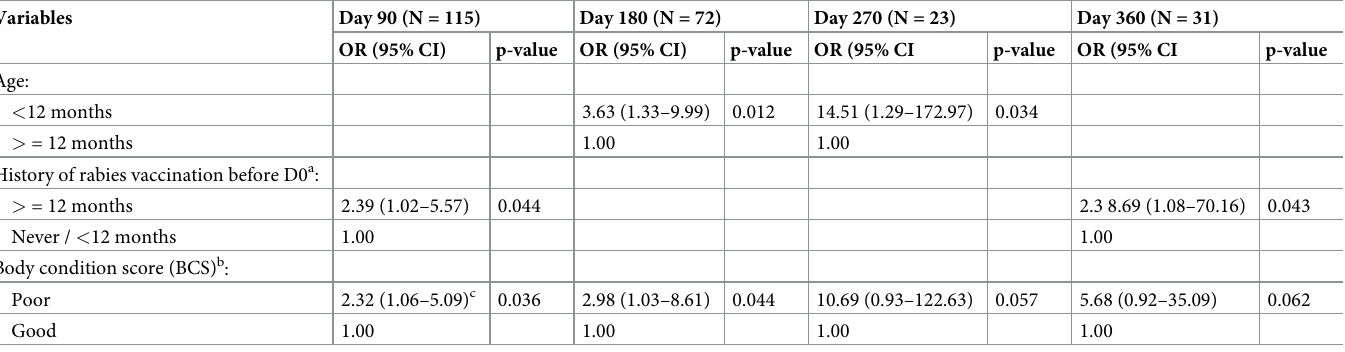
Table 4. Determinants associated with loss of adequate level of binding antibodies 90, 180, 270 and 360 days after rabies vaccination in dogs on Flores Island, Indo- nesia, using multivariable logistic regression analysis. All dogs showed an adequate rabies binding antibody titre of � 0.5EU/ml 30 days after vaccination.